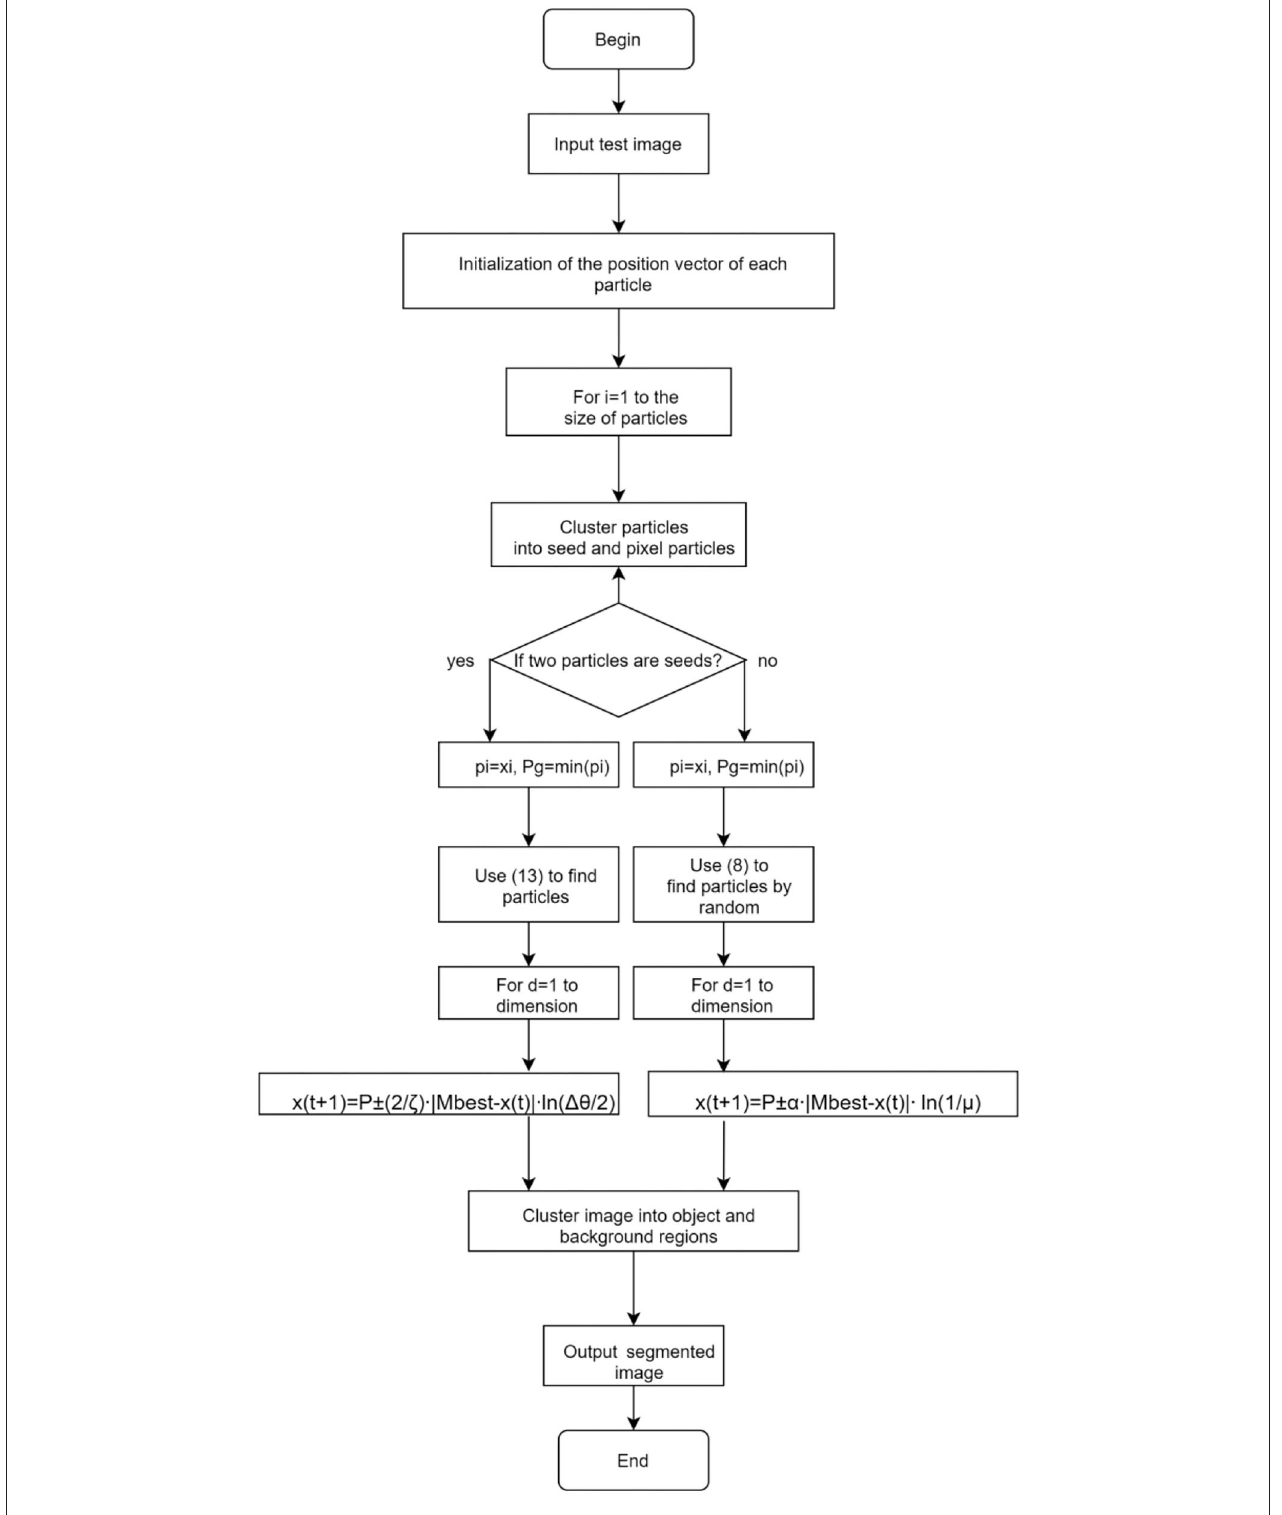
FIGURE 4 | Flow chart of the QWPSO